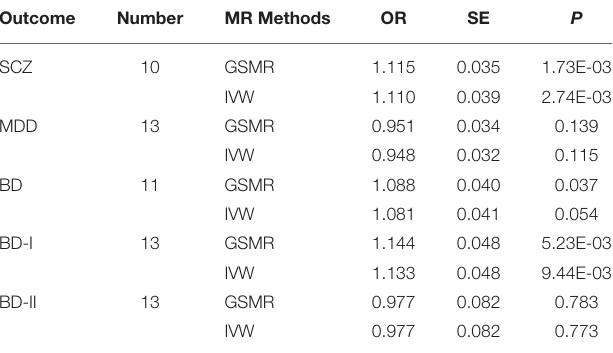
TABLE 2 | MR estimates of the causality between homocysteine level and three major psychiatric